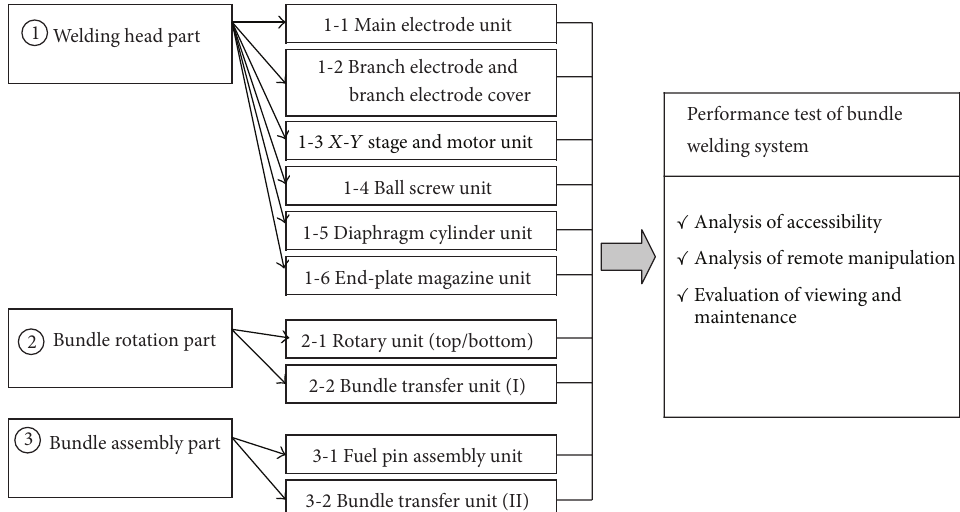
Figure 3: Basic concept of the remote welding equipment.